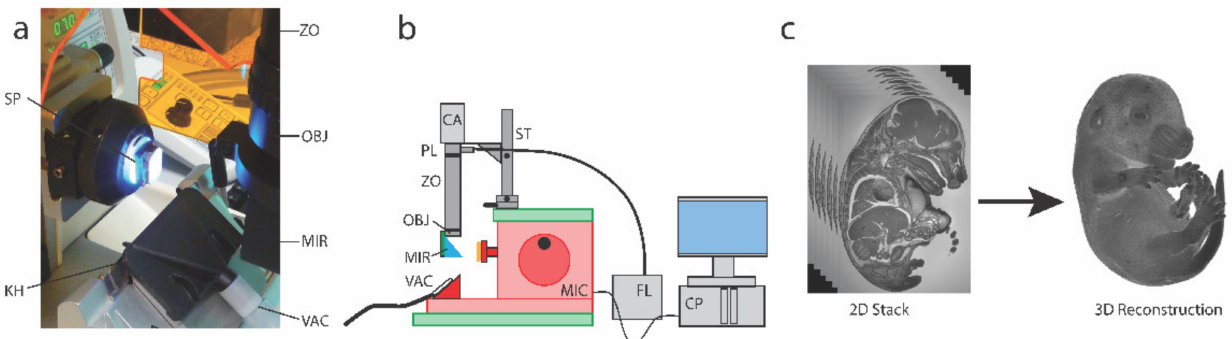
Figure 1. The microtome-integrated Histo3D optical system. ( a ) Detailed view of the block positioning for image capture. The block is positioned above the knife holder (KH). The excitation light passes through the zoom (ZO), the objective length (OBJ) and the mirror (MIR) to illuminate the sample (SP). The produced section is collected by the vacuum cleaner for each cutting-imaging loop. ( b ) The Histo3D apparatus is composed of the Leica Biosystem Nanocut Microtome (MIC) for the block sectioning step. The optical system is installed on a custom XYZ stage (ST) on the top of the microtome. The optical path is based on a custom fluorescence Ploem illuminator (PL) installed on a zoom (ZO) equipped with an objective lens (OBJ). To reduce the system footprint, the optical axis contains a mirror (MIR) in front of the objective lens for both sample highlighting and image collection. The block-face images are collected on the camera (CA). The fluorescence light is provided by a bright solid-state white light source (FL). The image acquisition and sectioning loop is computer-controlled using the Imagxcell Software Suite (CP), allowing the Histo3D system to perform block-face imaging of the sample with a fully automated procedure. For each cutting iteration, the produced section is collected by the vaccum system, equipped with HEPA filters. The Histo3D system does not modify the microtome and thus can be installed on an already existing Nanocut microtome. ( c ) Generation of 2D raw data images and 3D reconstruction of a whole mouse embryo at